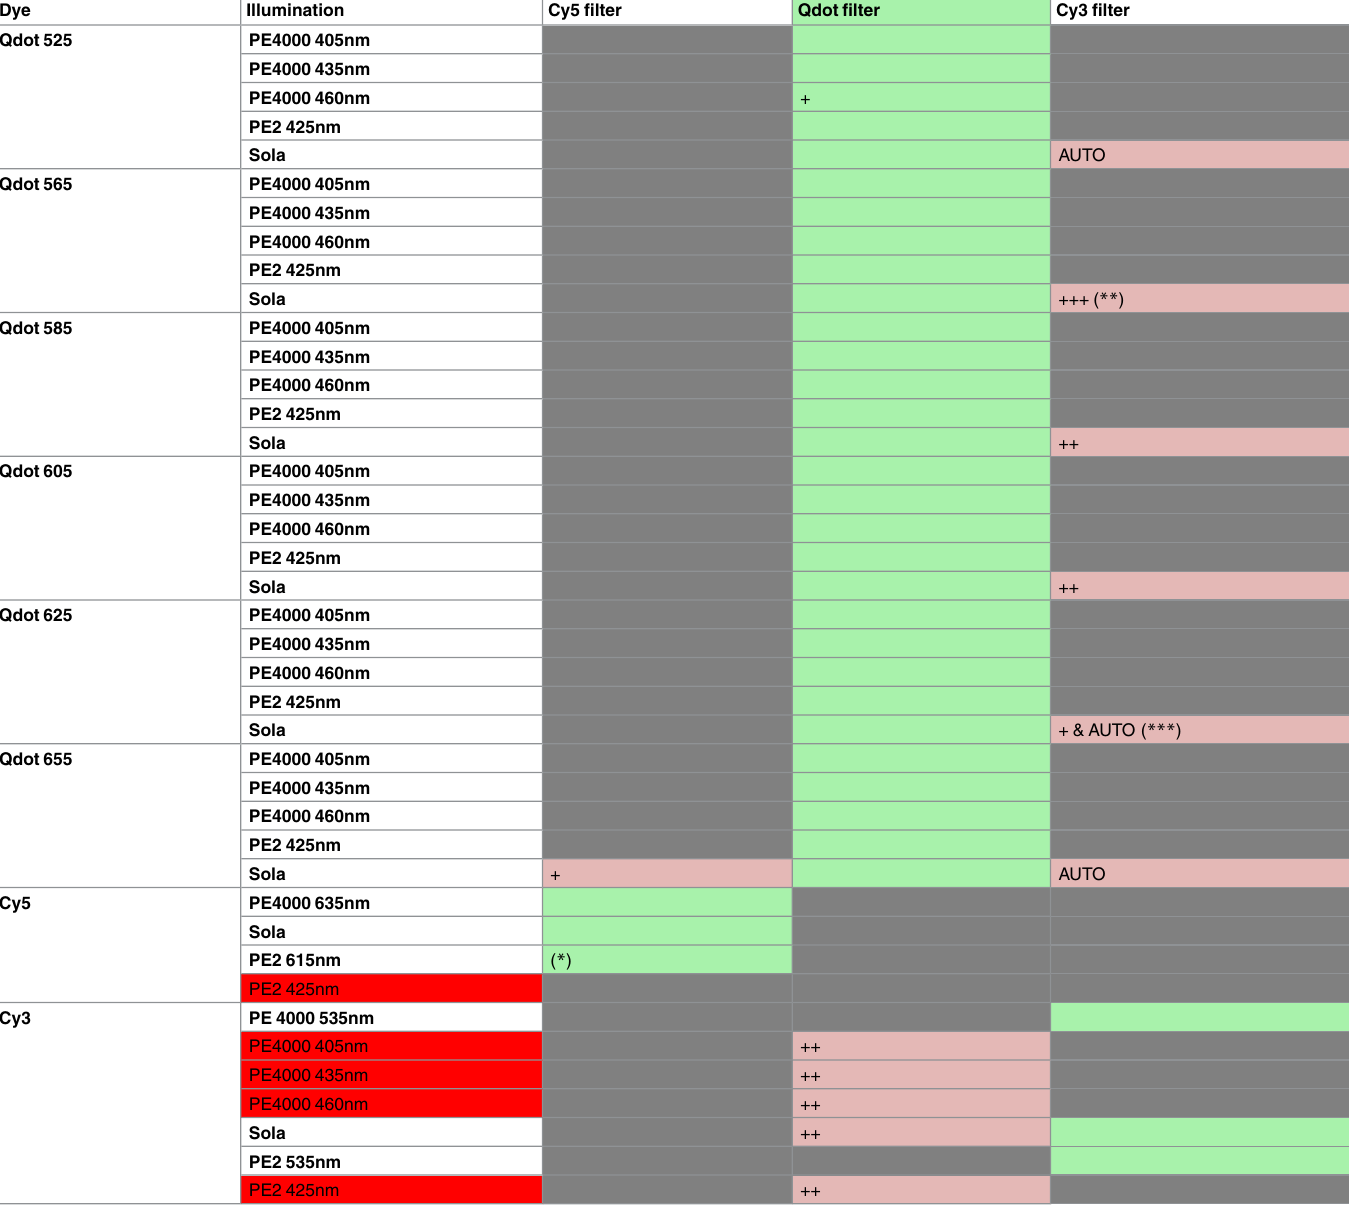
Table 7. Bleed throughtest.